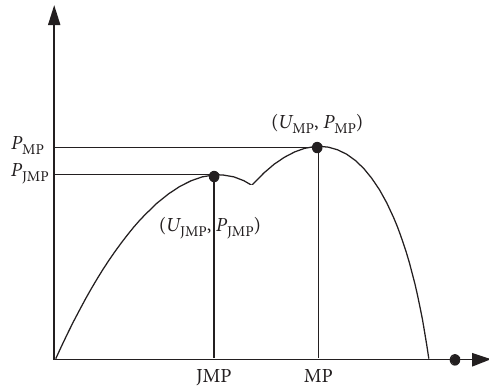
Figure 5: Bimodal characteristics of P - U curves of PV modules under shadow